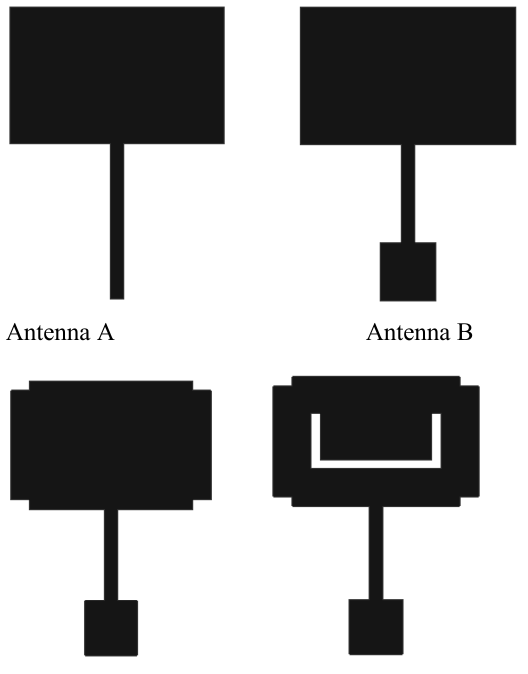
Fig. 5. S 11 optimization for different values of LGrd1